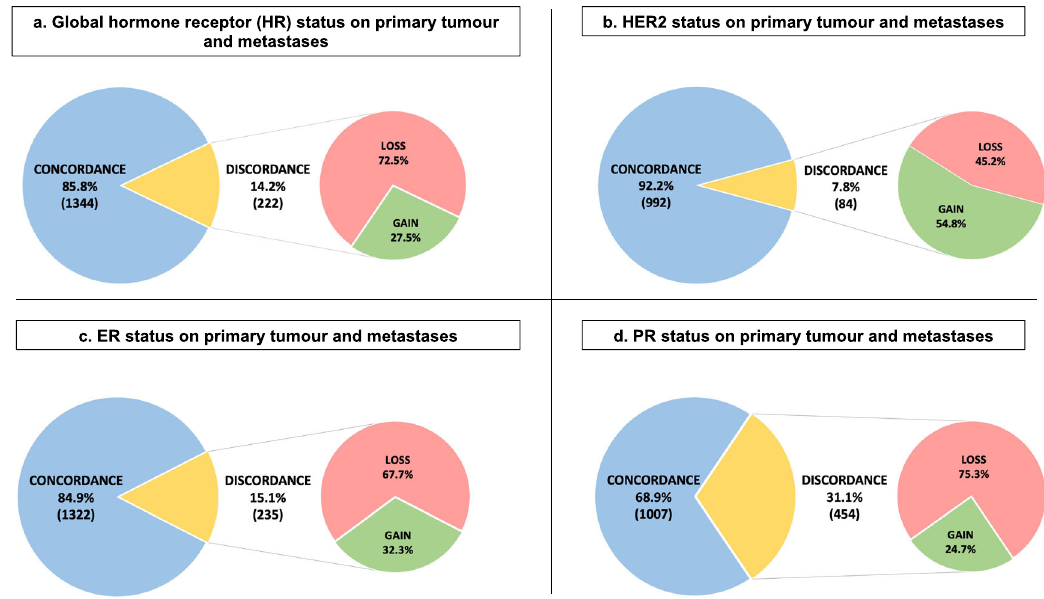
Fig. 2 Modi fi cation of ER, PR and HER2 status between primary tumour and metastasis. a Hormone receptor status on primary tumour and metastasis ( n = 1566), b HER2 status on primary tumour and metastasis ( n = 1076), c Estrogen receptor status on primary tumour and metastasis ( n = 1557), d Progesterone receptor status on primary tumour and metastasis ( n = 1461). HR Hormone receptor expression, HER2 human epidermal growth factor receptor 2, ER Estrogen receptor expression, PR Progesterone receptor expression.